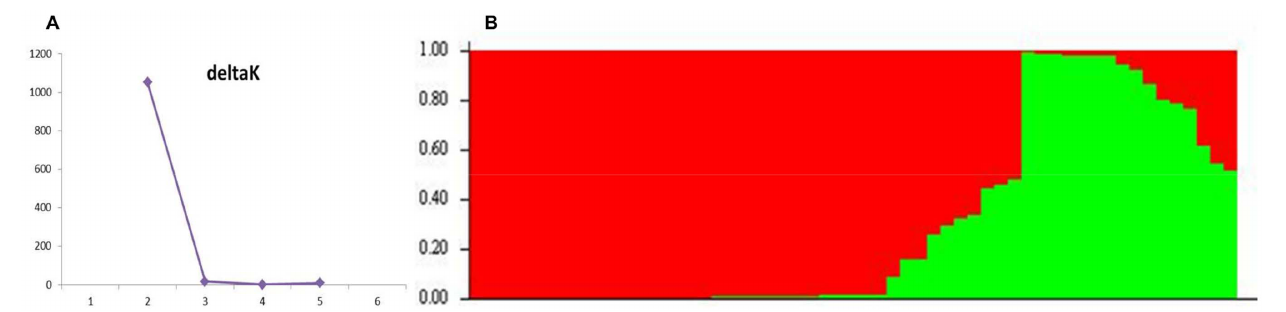
Figure 3. STRUCTURE analysis of 280 SNP markers over 56 turnip accessions. (A) Result of the K calculation, deltaK for K 5 2-6 revealed a single distinct peak at K 5 2; (B) Plot of the raw STRUCTURE output for two subpopulations (K 5